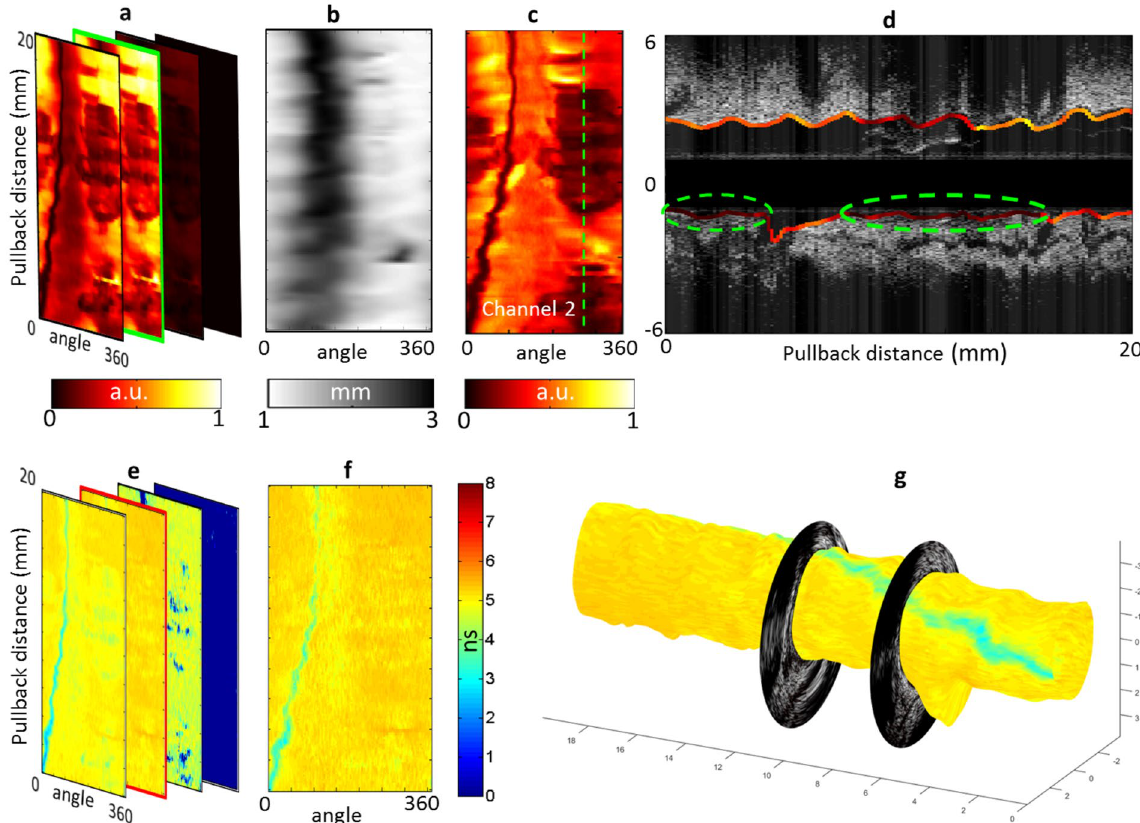
Figure 2. Ability to acquire co-registered FLIm/IVUS data in vivo in coronary arteries was evaluated in swine. Intensity en face image of a section of left circumflex artery acquired in vivo in pig ( a ). A distance map derived from IVUS ( b ) enables distance correction of the intensity image ( c ). For each of the four channels, a lifetime image is derived ( e ). Channel 2 presents the most fluorescence due to presence of collagen and elastin and shows very uniform background as expected from a healthy pig ( f ). The FLIm data can be combined with IVUS to provide bimodal 3D renderings ( g ) as well as sections of the vessel ( d ) (30° orientation, corresponds to the dashed line of panel